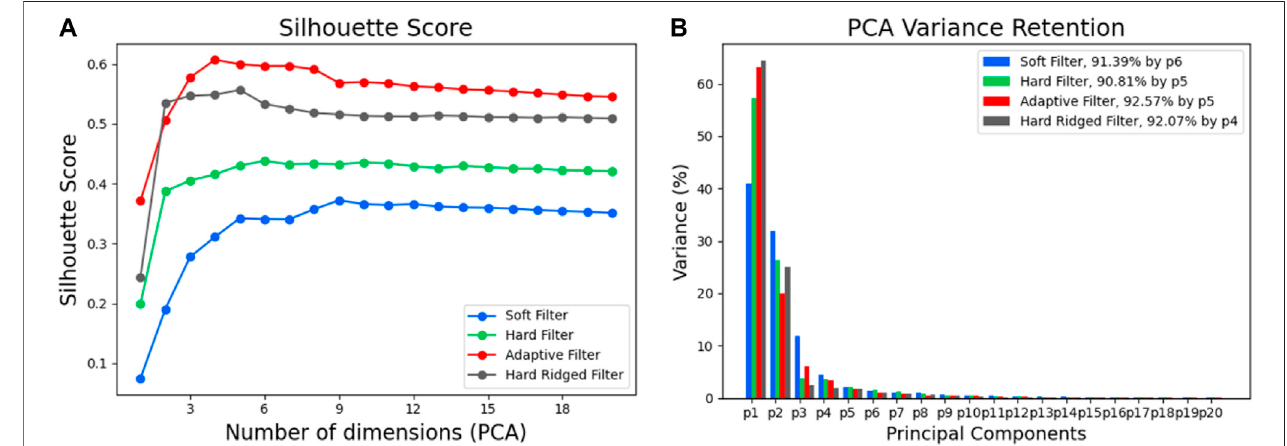
FIGURE 7 | (A) The silhouette score for increasing number of dimensions for the different fi lters when classifying the different objects. (B) The variance in the principle components for the different fi lters.